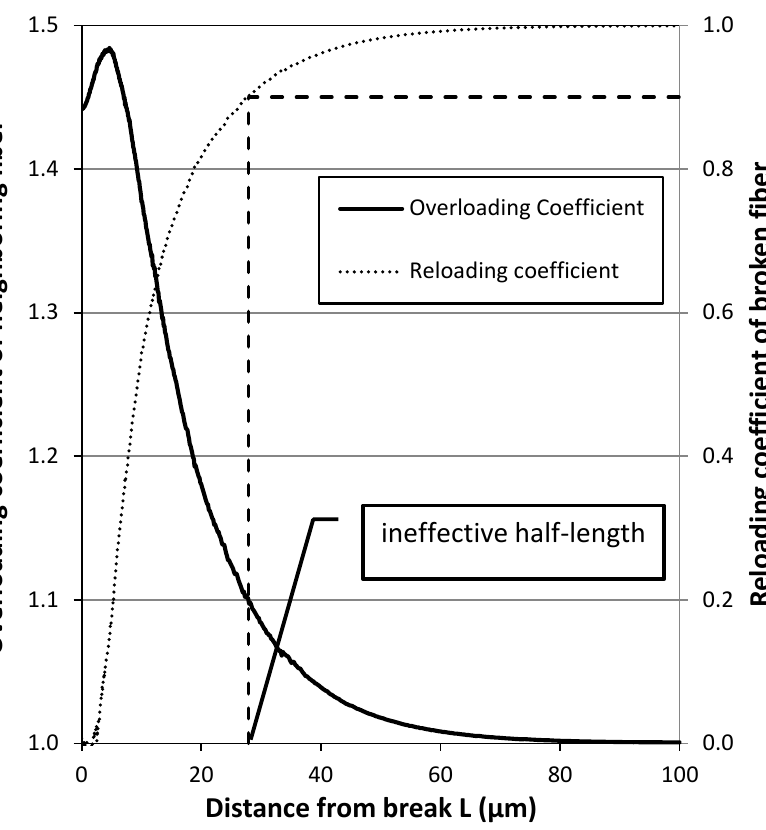
Figure 5. Evolutions of the reloading coefficient of a broken fiber and of the overloading coefficient of the neighboring fiber with a non-reinforced